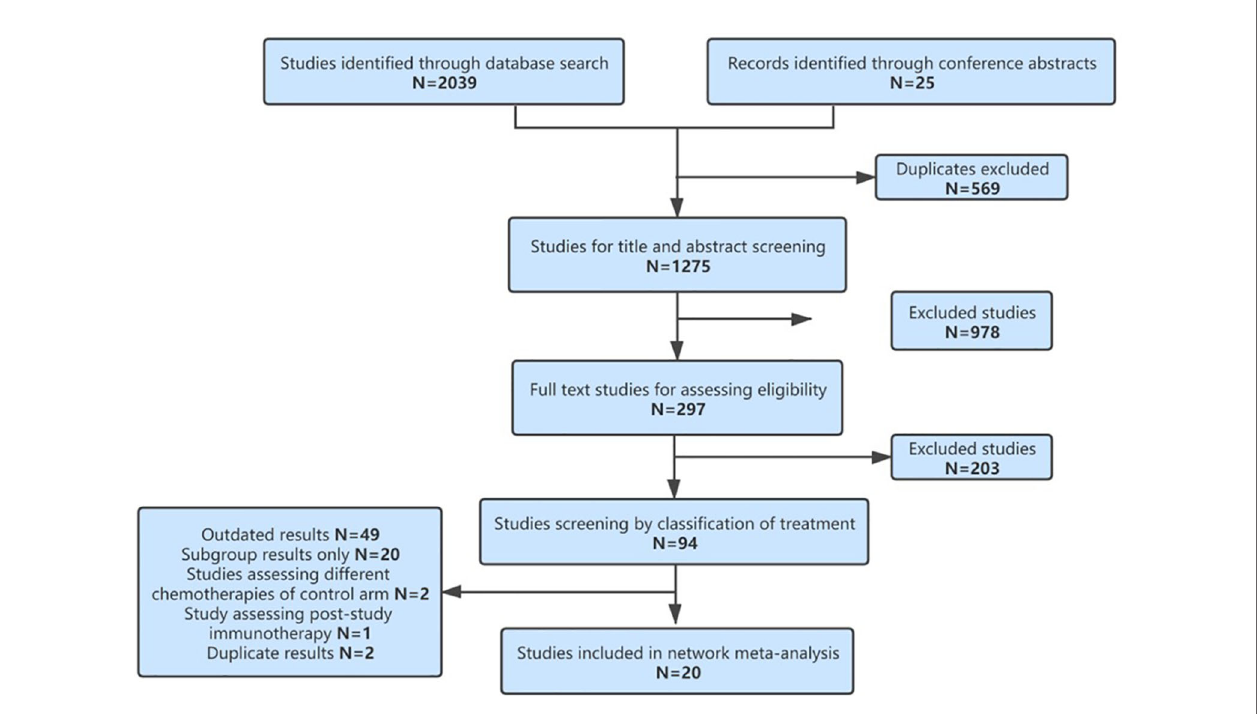
FIGURE 1 | Flowchart of study